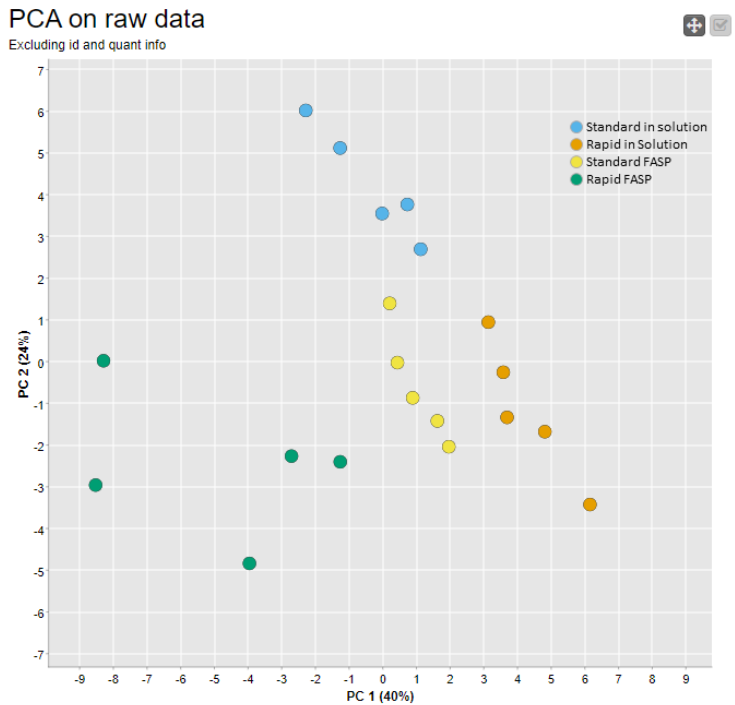
Figure 4. Raw data quality assessment: combined analysis of all raw data QC features using principal component analysis (PCA). CSF samples were digested using different approaches, with five replicates each for standard in-solution digestion (blue), rapid in-solution digestion (orange), standard FASP (yellow), and rapid FASP (green). Using MaCProQC, a PCA plot based on raw data features was created in order to visualize inter- and intragroup variability in the four sample datasets. PCA based on the raw data features showed the lowest level of replicate clustering for rapid FASP, testifying to the limited reproducibility of the preparation.